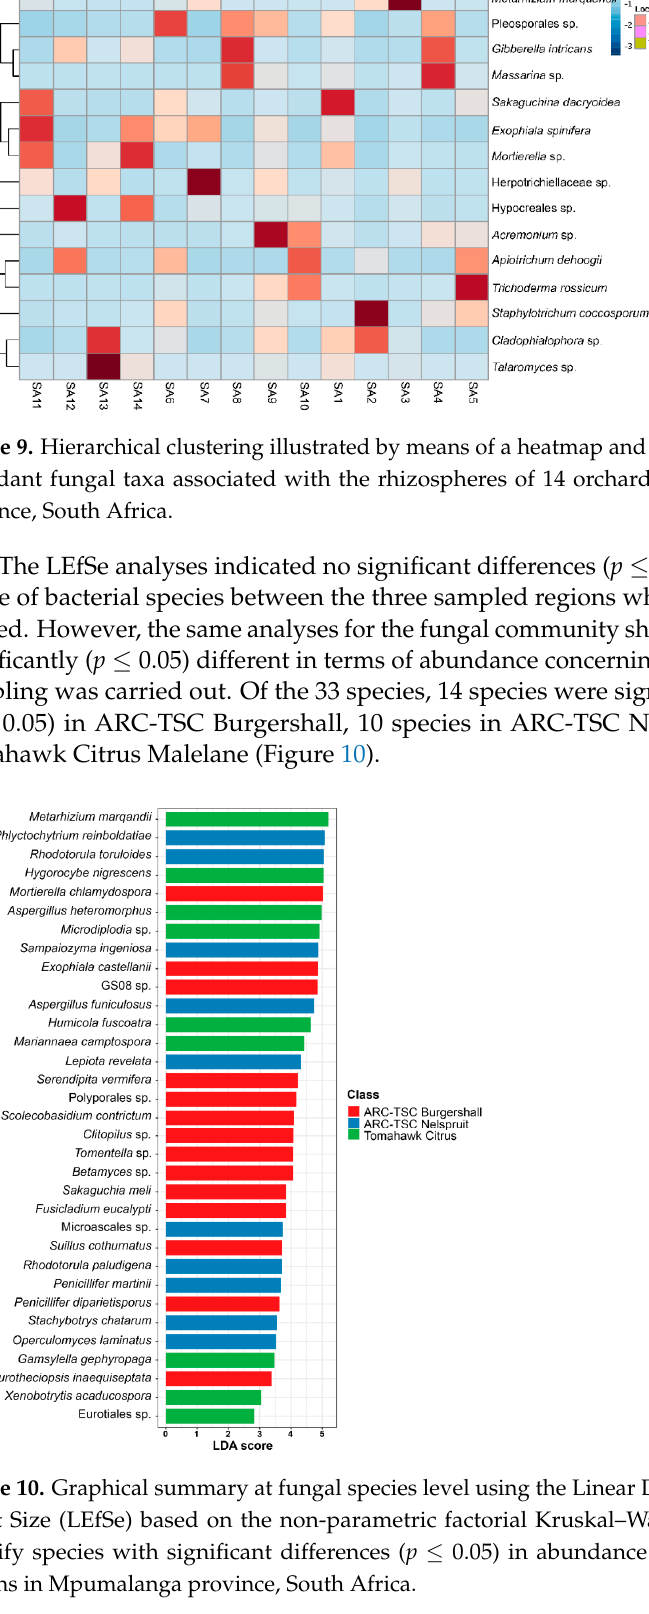
Figure 10. Graphical summary at fungal species level using the Linear Discriminant Analysis (LDA) Effect Size (LEfSe) based on the non-parametric factorial Kruskal–Wallis (KW) sum-rank test to identify species with significant differences ( p ≤ 0.05) in abundance among the three sampling regions in Mpumalanga province, South Africa.